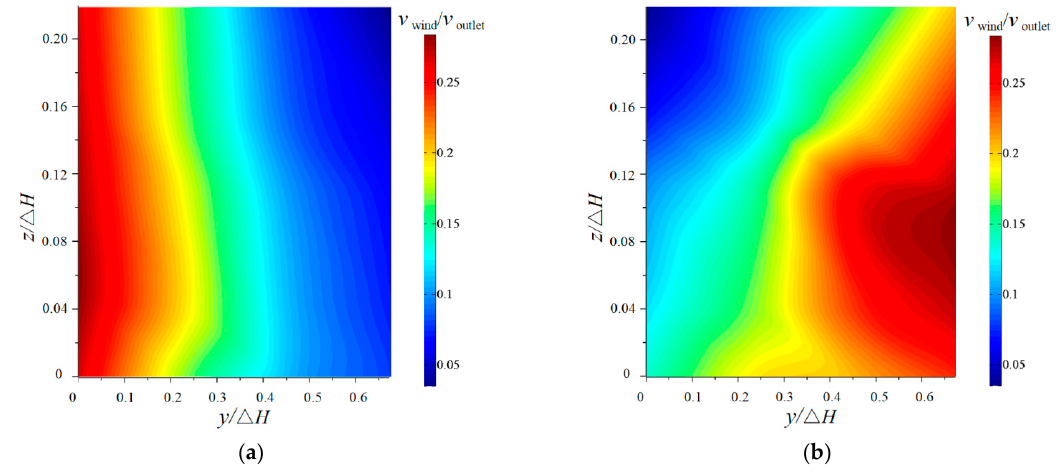
Figure 9. Vertical distribution of velocity of the nappe wind ( x/ Δ H =3.04): (a) CB and (b) TB.